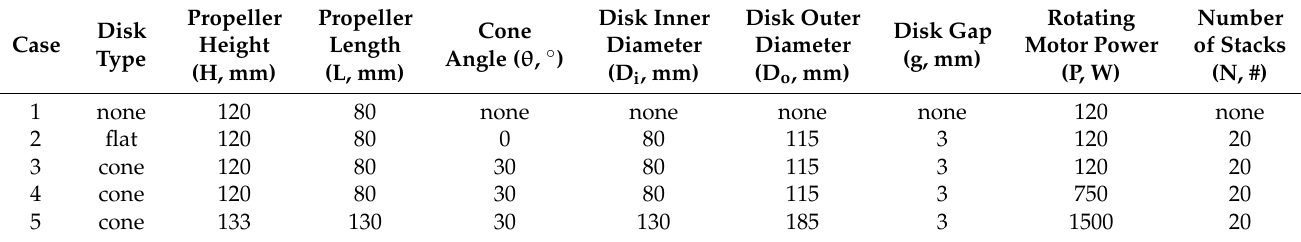
Figure 2. Schematic of a disk-stack centrifugal cyclone separator: ( a ) cyclone with 120 W motor, ( b ) cyclone with 750 W motor, ( c ) cyclone with 1.5 kW motor. Table 1. Dimensions of the experimental cyclones.